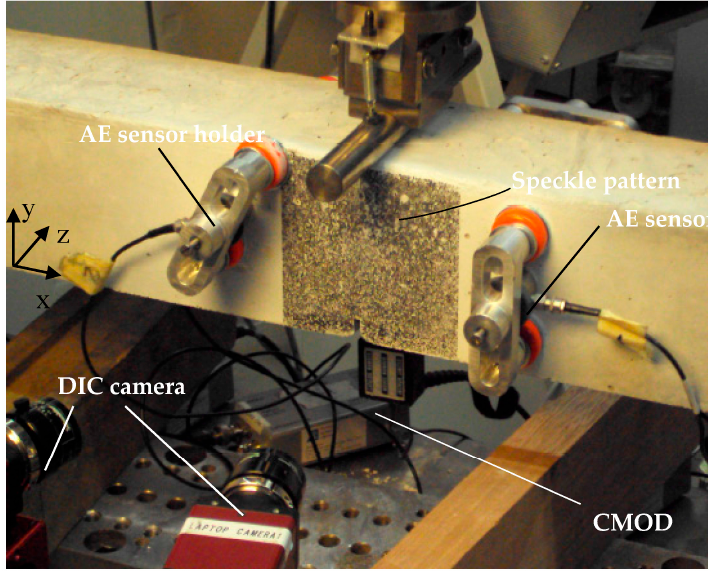
Figure 19. Experimental set-up for three-point-bending with AE-sensors and DIC speckle pattern.